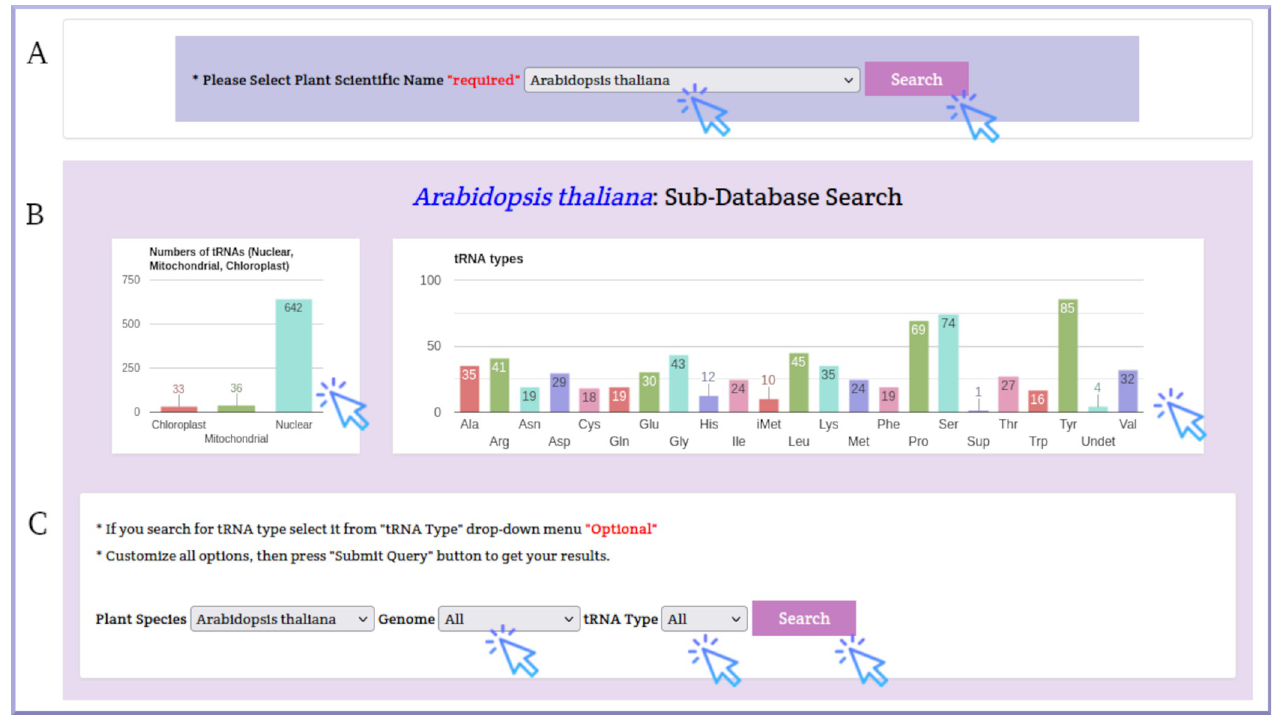
Fig 3. Arabidopsis thaliana search page as an example of PltRNAdb search. A) Select the plant species dropdown menu, B) bar charts represent statistics of all data available for Arabidopsis thaliana in PltRNAdb, C) Genome and tRNA dropdown menus for Arabidopsis thaliana search in PltRNAdb.